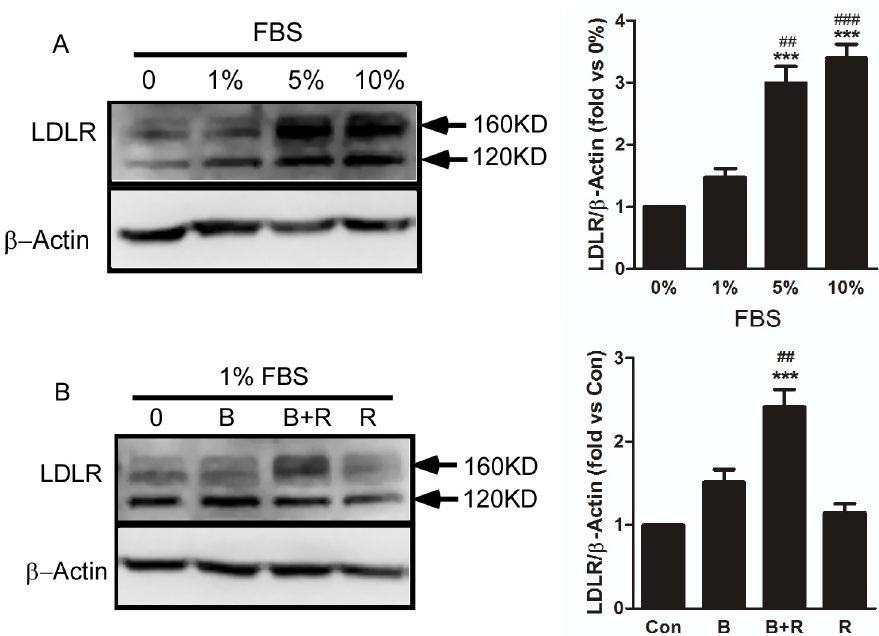
Figure 4. The combination of berberine with resveratrol increased LDLR expression in HepG2 cells. Cells were cultured in 6-well plate for 24 h with a 3 × 10 5 cell density, and then culture medium were replaced by fresh medium containing different concentration of FBS indicated in A, or 1% FBS and drugs indicated in B for another 24 h followed by extraction of the total proteins from the cells. A : the effect of different concentration FBS on LDLR expression were analyzed by western blot assay. Then the band intensity was quantified by grey scanning analysis, and the intensity ratio of LDLR to β -actin in 0% FBS group was set to 1. *** p < 0.001 vs. 0% FBS group, ### p < 0.001, ## p < 0.01 vs. 1% FBS group. B : effect of the combination 12 µ mol/L berberine (B) with 10 µ mol/L resveratrol (R) on LDLR expression. The intensity ratio of LDLR to β -actin in untreated control group was set to 1. *** p < 0.001 vs. untreated control, ## p < 0.01 vs. single Ber or Res treatment. The results are representative of three separate experiments.